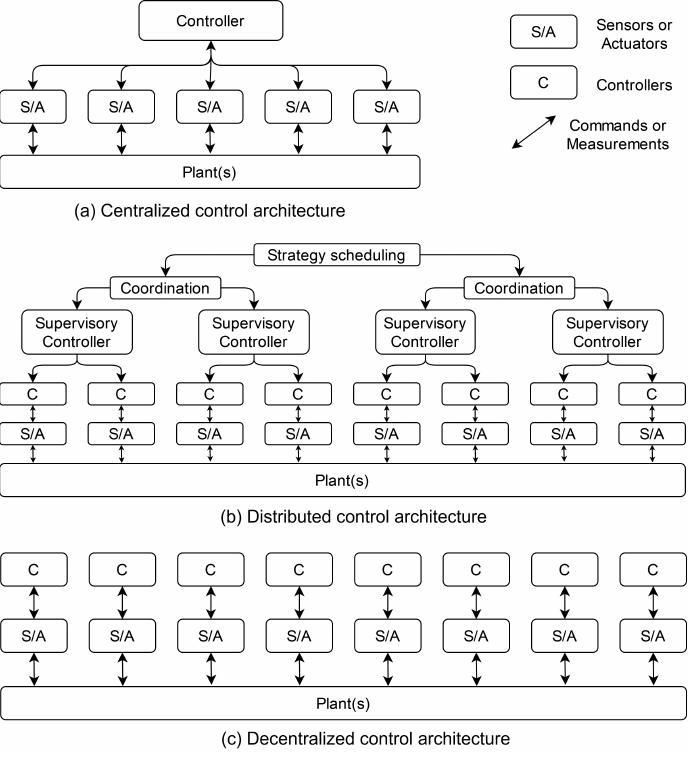
Figure 3. Control